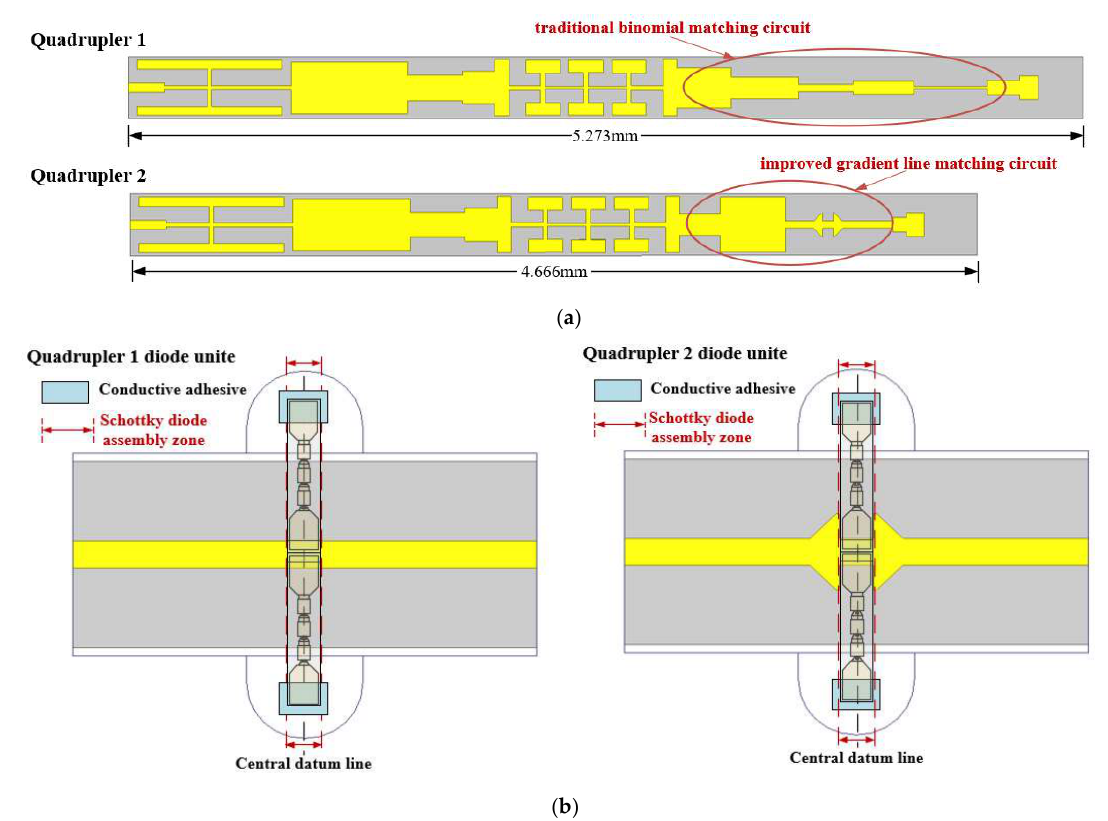
Figure 4. ( a ) Comparison of circuit structures; ( b ) comparison of diode